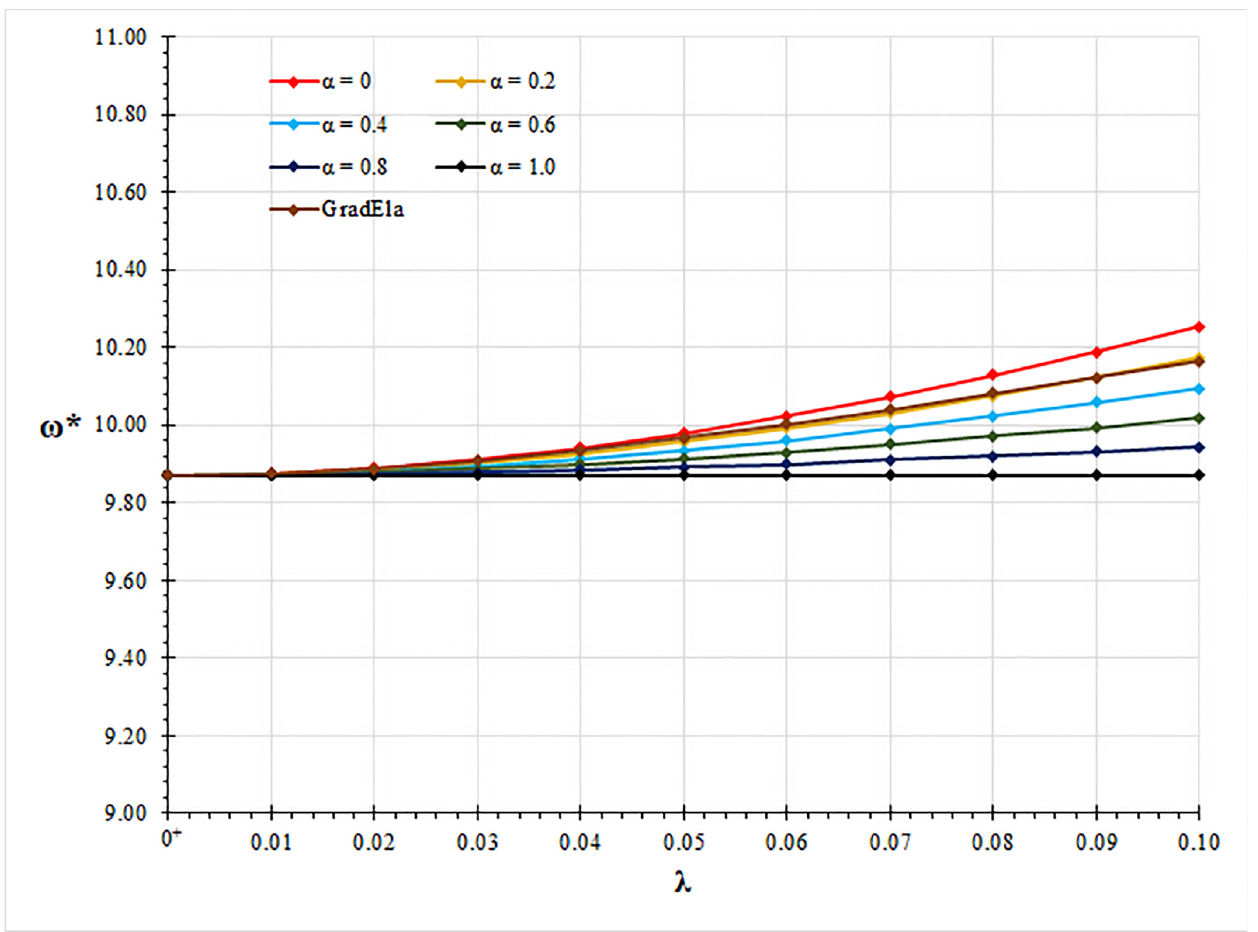
Figure 3. Pinned-pinned beam: non-dimensional fundamental natural frequency ω ∗ vs. nonlocal parameter λ for α ∈ { 0, 0.2, 0.4, 0.6, 0.8, 1.0 } .